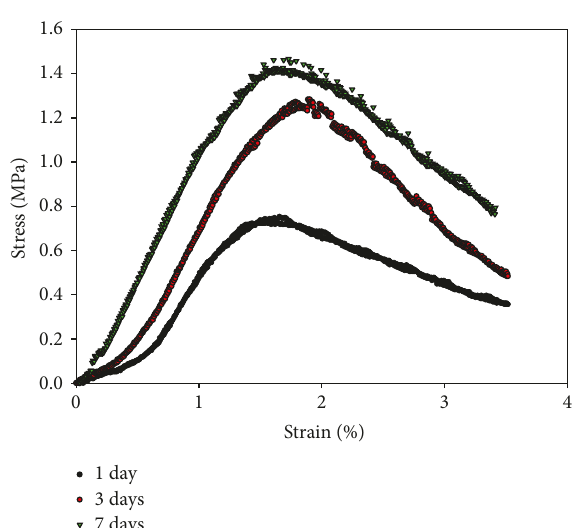
Figure 5: Stress-strain curve at different curing